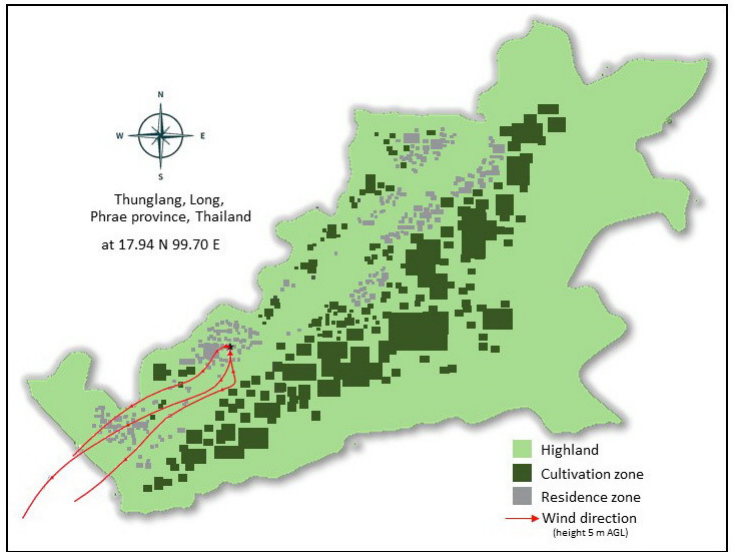
Figure 1. The geography of Thung Lang subdistrict, Long district, Phrae province, Thailand.